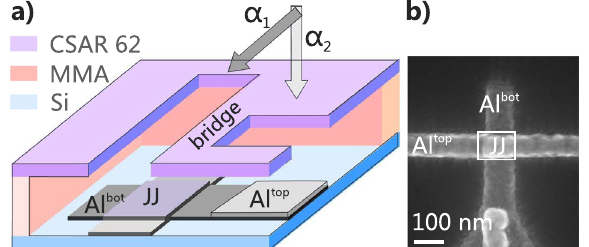
Figure 1. Niemeyer–Dolan bridge technique used in this paper. ( a ) Scheme of the used shadow evaporation process. The first metal layer was deposited at an angle (dark grey color) through two-layer resist mask MMA- CSAR, and the second layer at 0 angle (light grey color). Angular deposition was performed first, in order to avoid shading from the junction wall at the second deposition, causing electrode discontinuity. ( b ) Top view SEM image of the fabricated junction after the removal of the resist